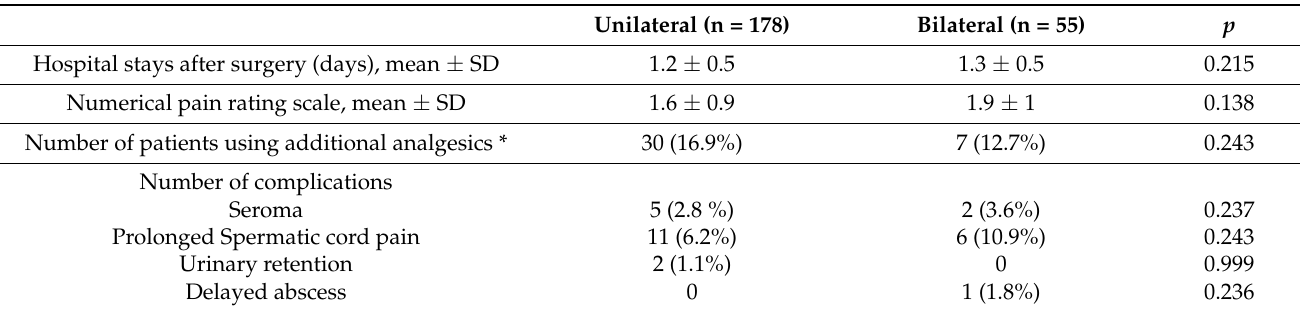
Table 3. Postoperative outcomes and complications.